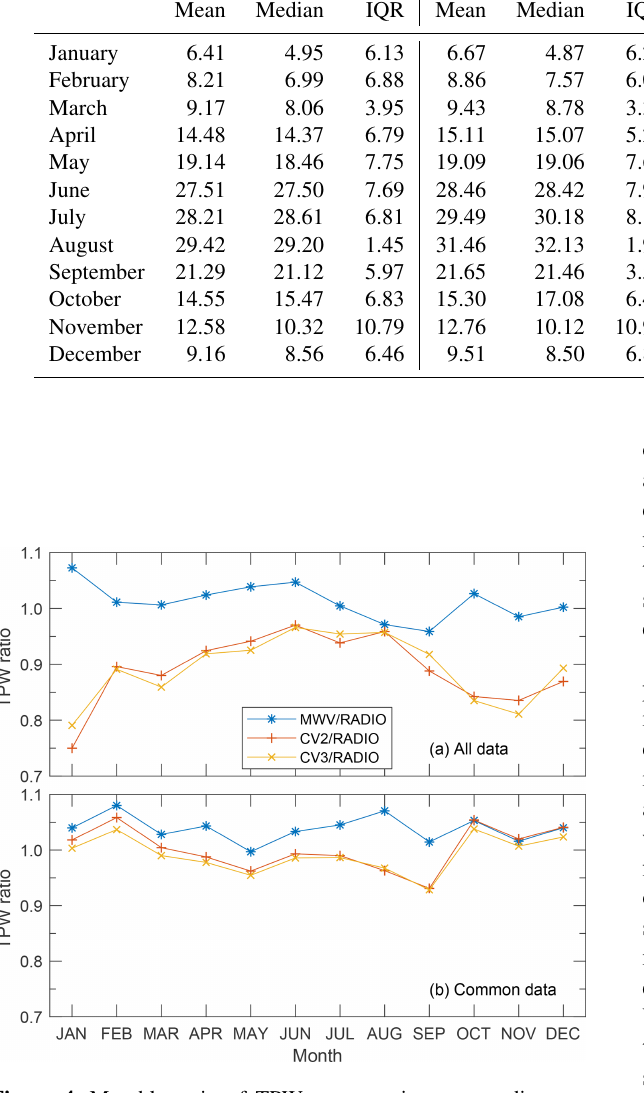
Table 5. Same as Table 3 but just for the common measurements. All units are in millimetres. Radiosondes Month